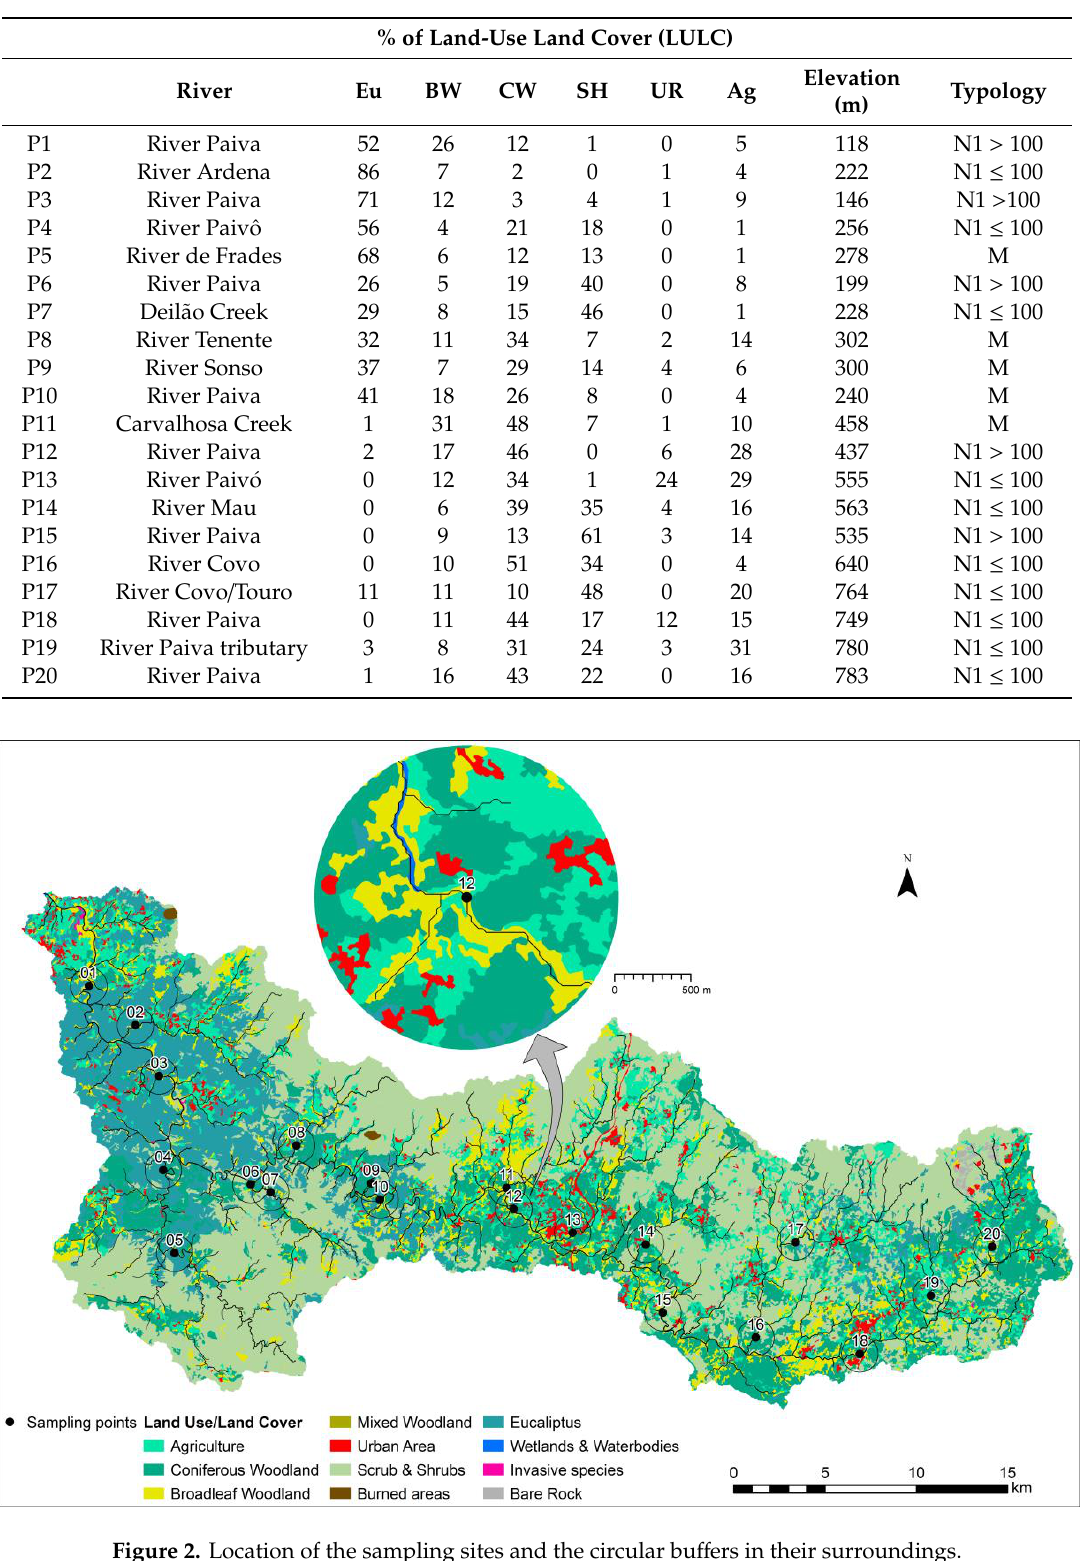
Figure 2. Location of the sampling sites and the circular buffers in their surroundings.